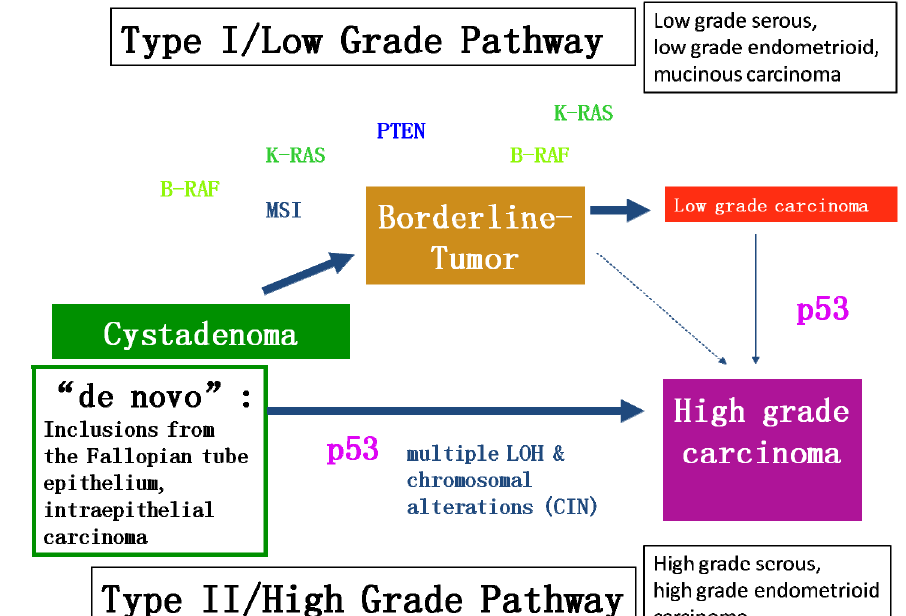
Figure 3. Molecular tumorigenesis of type I and type II ovarian carcinoma (modified according to Kurman, Shih 2004, Lax